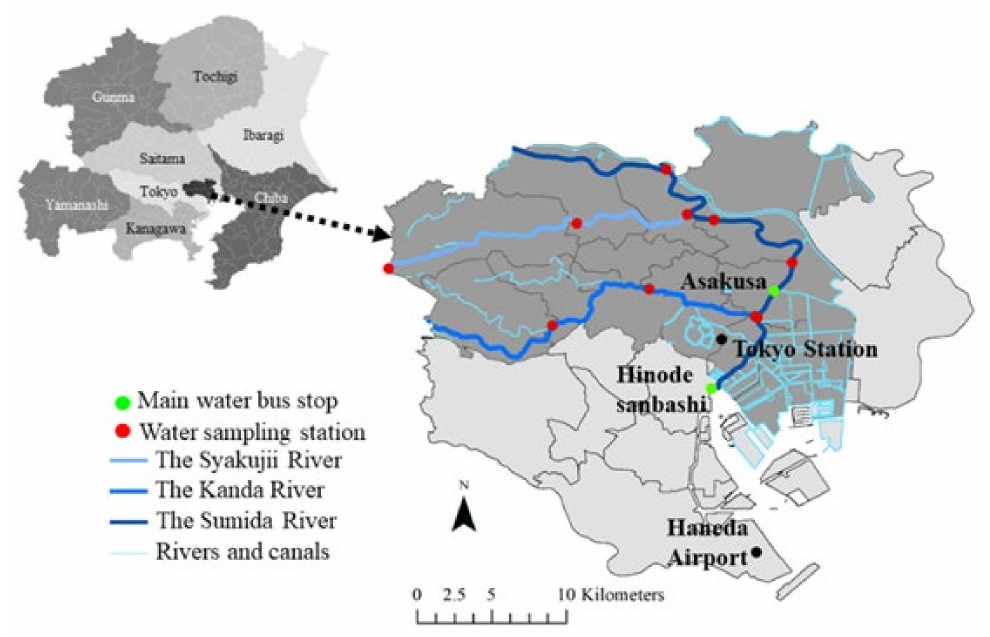
Figure 1. Study area map with major location points. The map includes the 23 wards of Tokyo. Wards in dark grey belong to the Sumida River Basin.